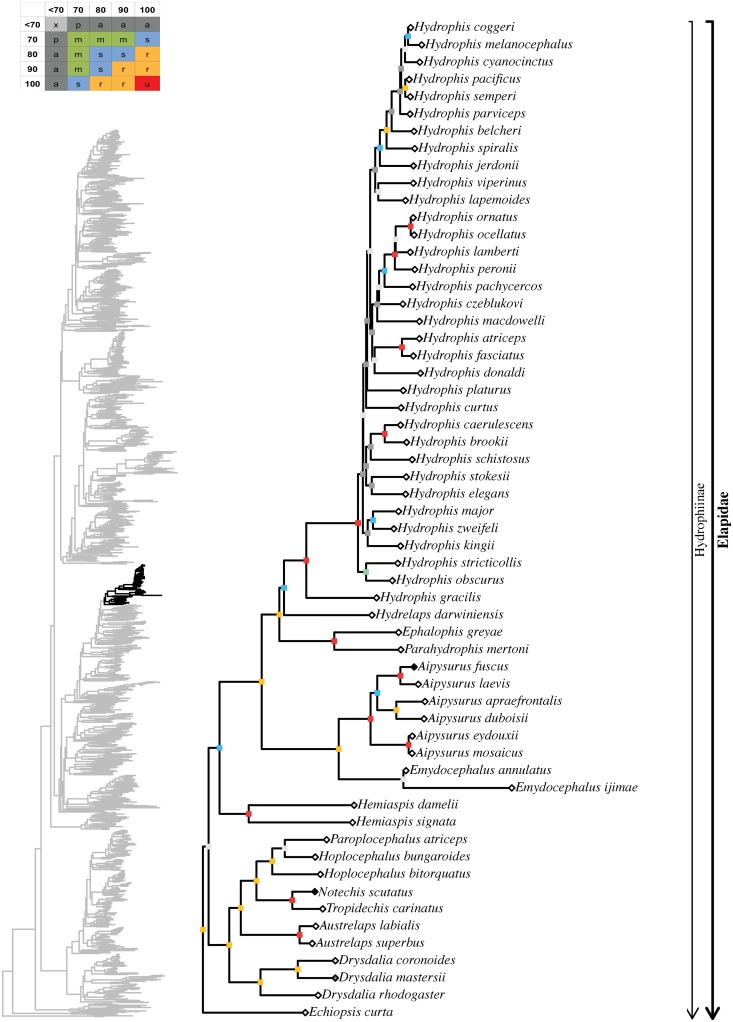
Maximum likelihood species-level phylogeny of Colubroides
(continued).Family Elapidae (continued).